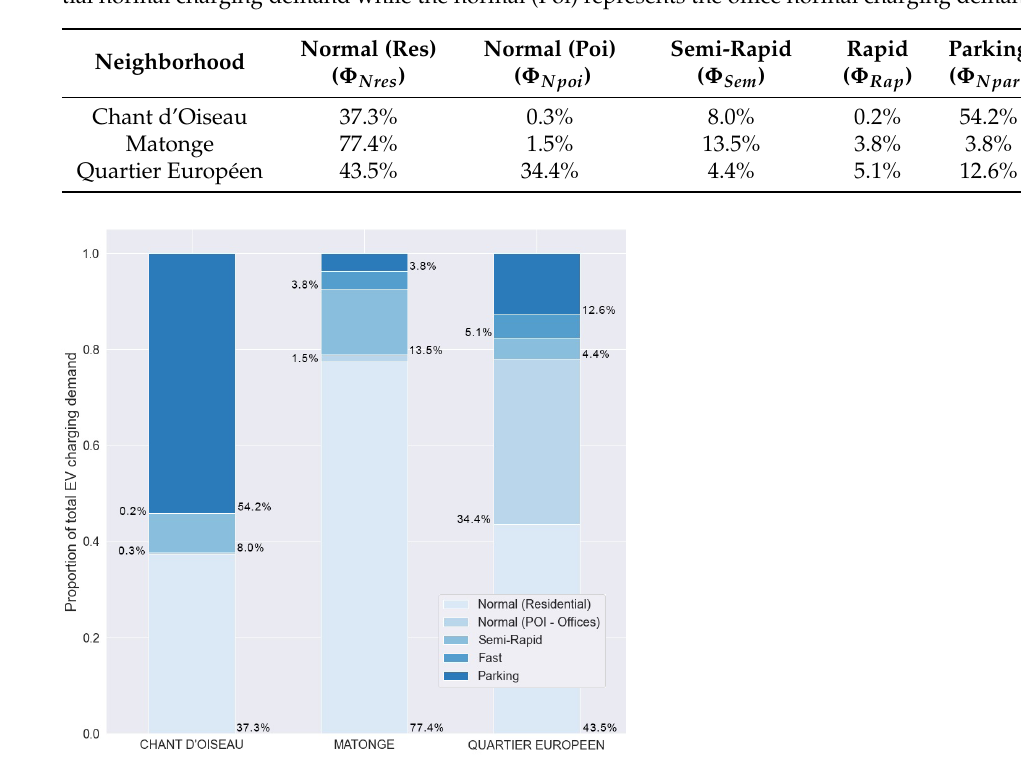
Figure 7. Segmentation results for three different neighborhoods ( Chant d’Oiseau , Matonge , Quartier Européen ). The y-axis shows the percentage of each charging technology. It is interesting to compare these proportions with Figure 8, which highlights the different POIs included in each